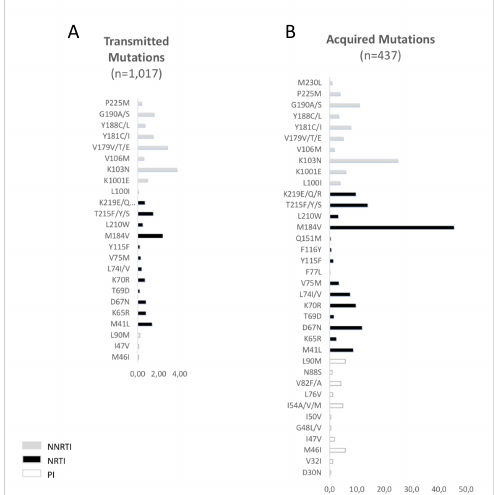
Figure 3. Proportion of human immunodeficiency virus (HIV) mutations in ( A ) drug-naïve patients and ( B ) treated patients between 2001 and 2017.